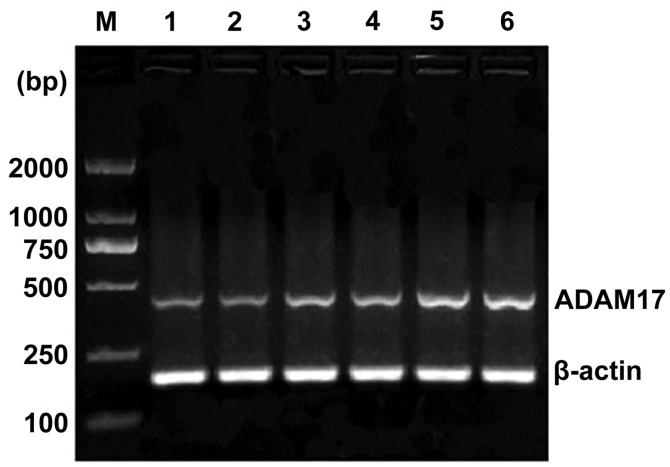
ADAM17 mRNA reverse transcription polymerase chain reaction amplification results electrophoresis. Lanes: M, DNA Marker; 1 and 2, histological grade I; 3 and 4, histological grade II; 5 and 6, histological grade III.